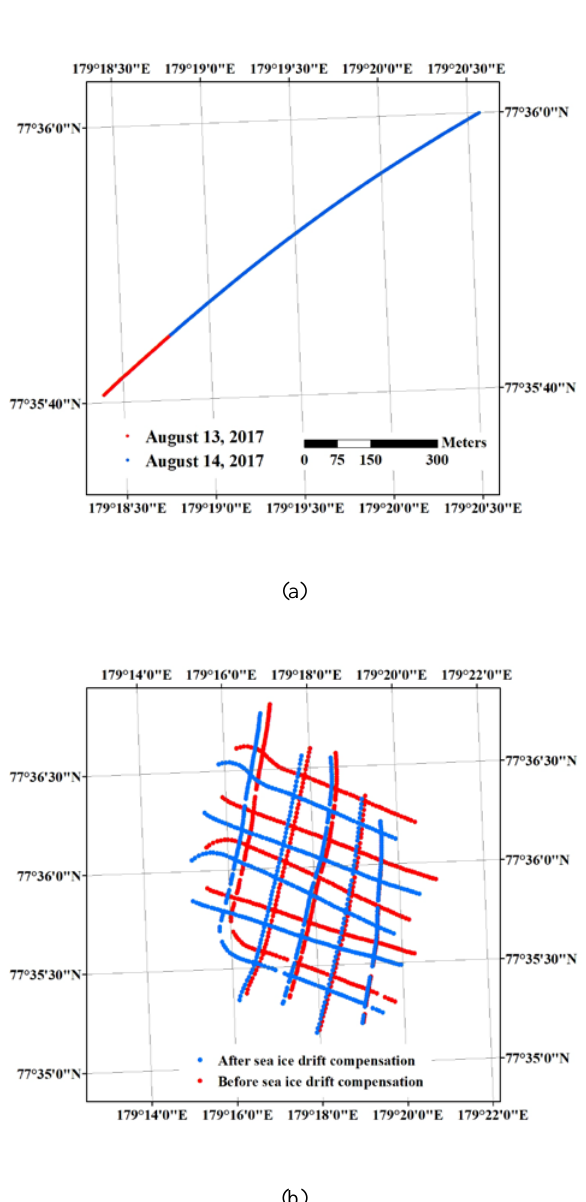
Figure 4. Compensation of sea ice drift in the VHR images: (a) trajectory of sea ice drift recorded from August 13, 2017 23:44:00 (UTC) to August 14, 2017 01:03:00 (UTC) recorded in IBRV Araon anchored to ice floe and (b) the image acquisition positions before and after compensation of sea ice